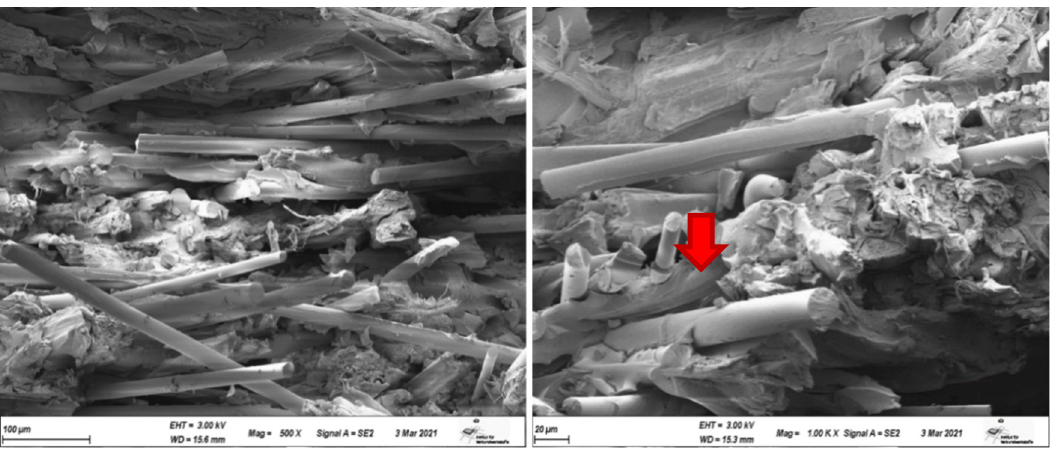
Figure 12. SEM analysis of D/23BA/KEFL composite (wide and close view).